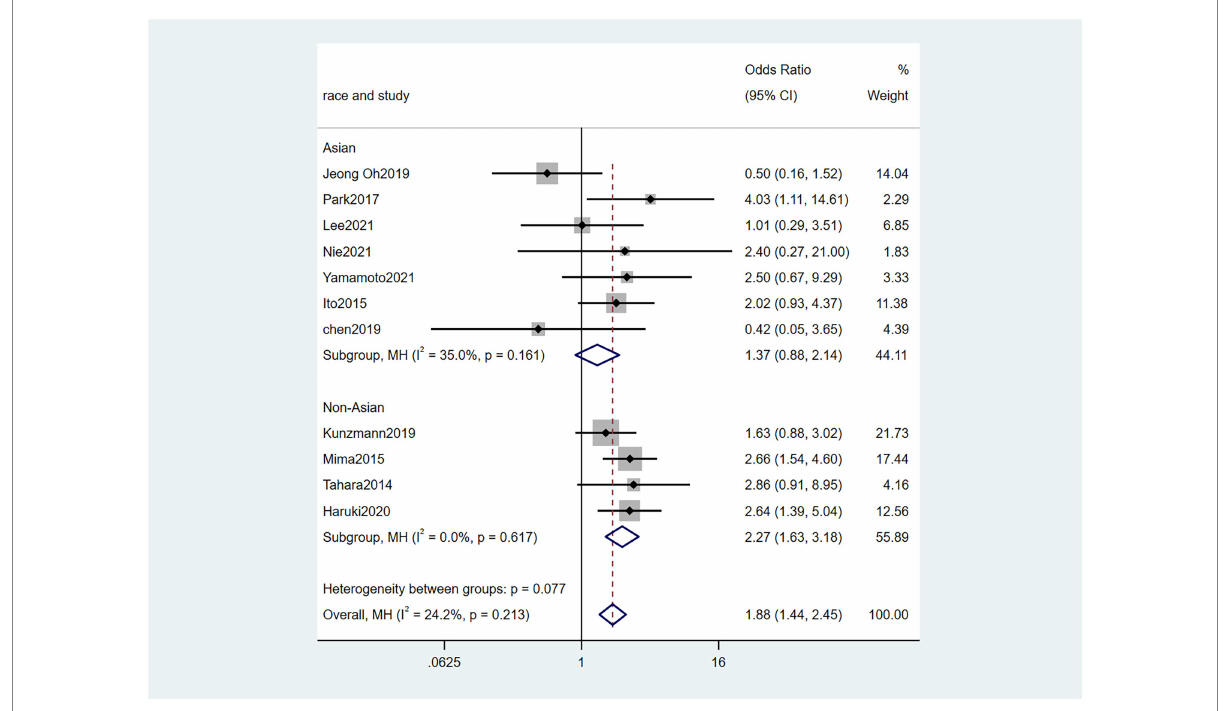
FIGURE 10 Forest plot of the relationship between Fusobacterium nucleatum and BRAF mutation in